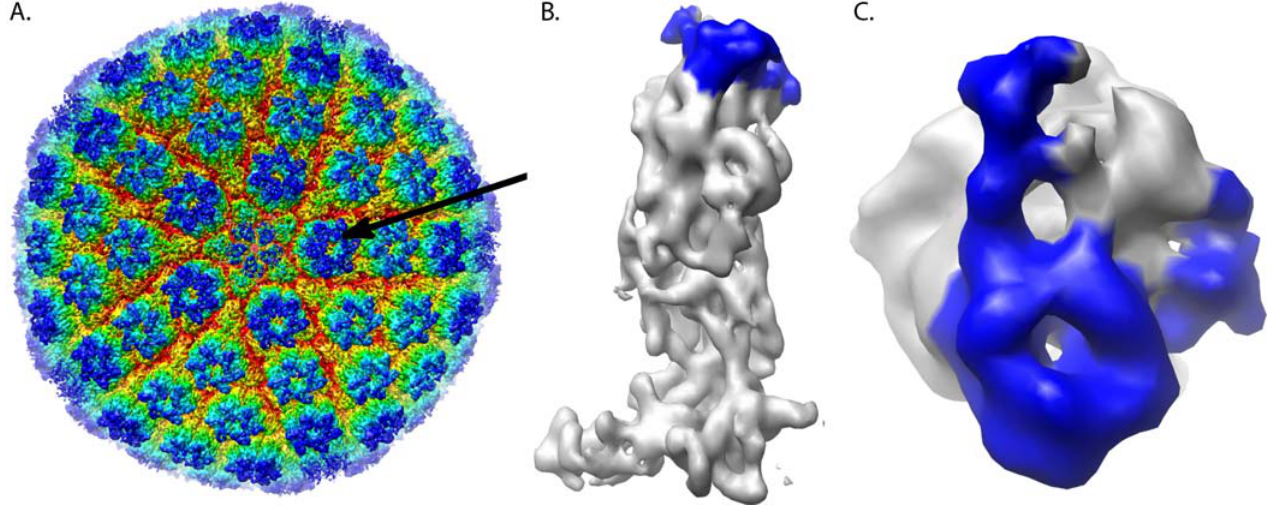
Figure 2. Structure of HSV-1 Hexon Subunit (A) The 8.5-A˚ resolution cryoEM structure of HSV-1 is shown radially colored. A hexon is indicated with an arrow. (B) The density of a single hexon subunit segmented from the 8.5-A˚ cryoEM map of the HSV-1 capsid is shown. (C) A top view of the hexon subunit is shown. VP26 shown in blue in (B) and (C) was isolated based on the difference map between the cryoEM density map of the hexon subunit and the VP5 upper-domain crystal structure. DOI: